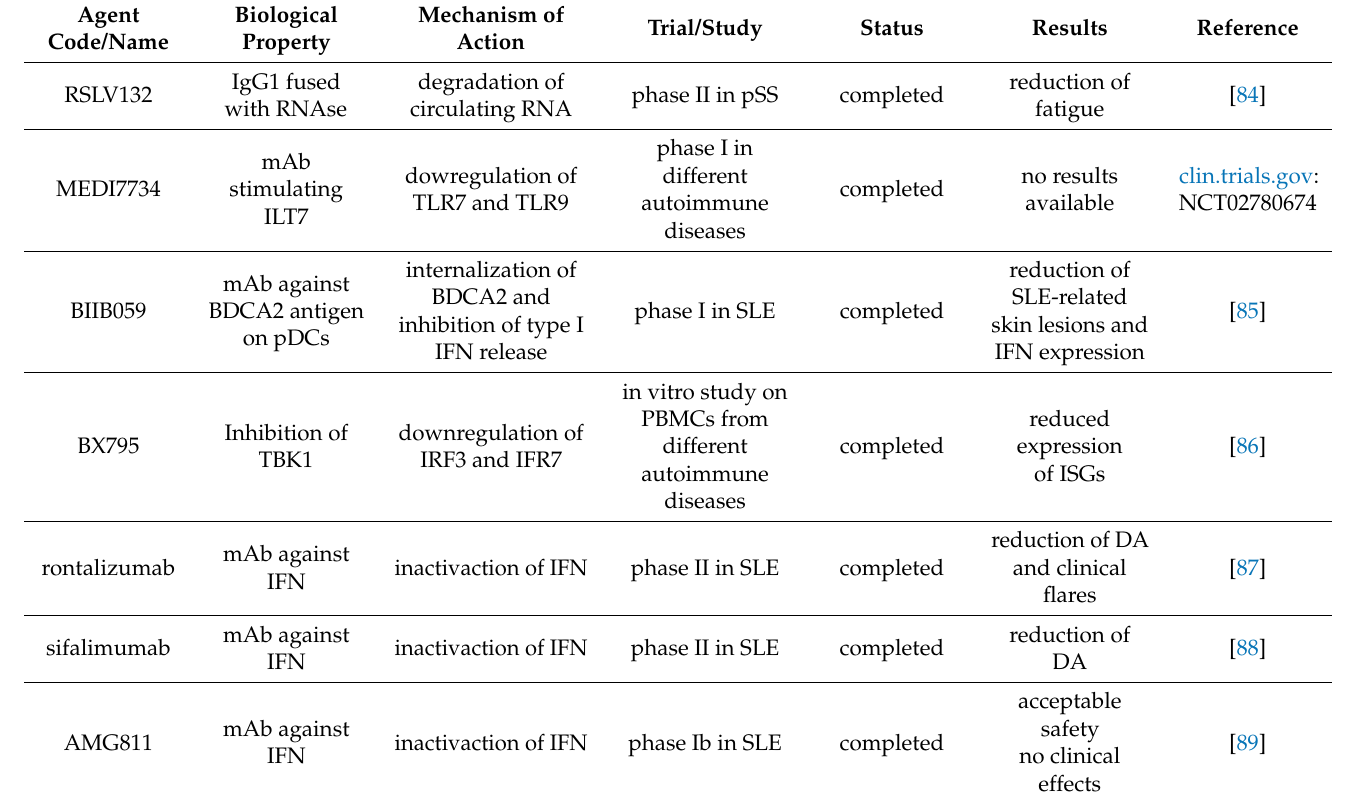
Table 2. Targeted therapies interfering with the activation of Interferon (IFN)